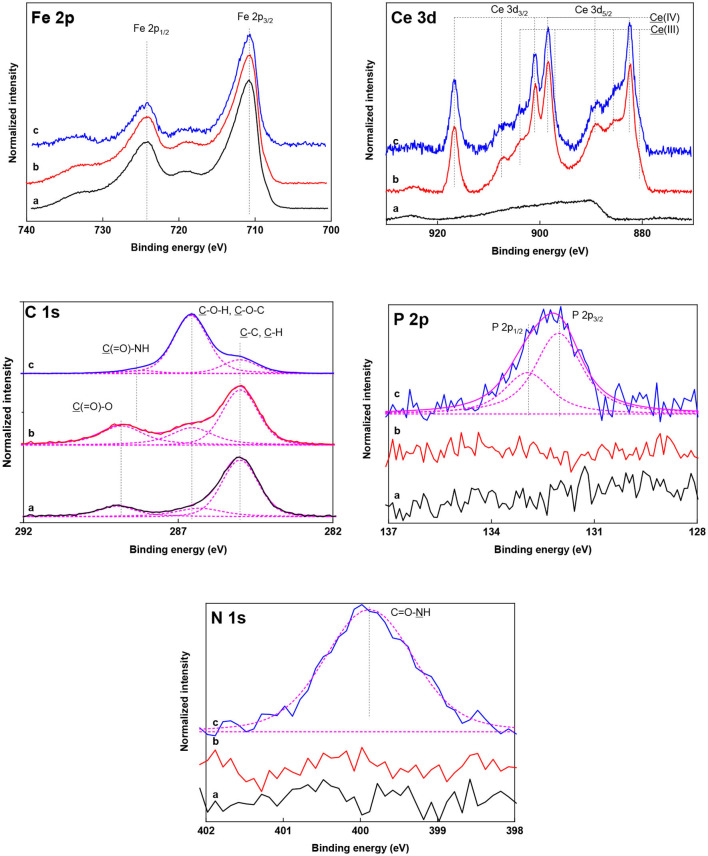
High-resolution Fe 2p, Ce 3d, C 1s, P 2p, and N 1s XPS spectra of (a) γ-Fe2O3, (b) γ-Fe2O3/CeOx, and (c) γ-Fe2O3/CeOx@PEG2,000 nanoparticles. Spectra and their resulting fitted envelopes are presented with full and magenta lines, respectively. Individual contributions of the fitted curve are presented with dashed lines.